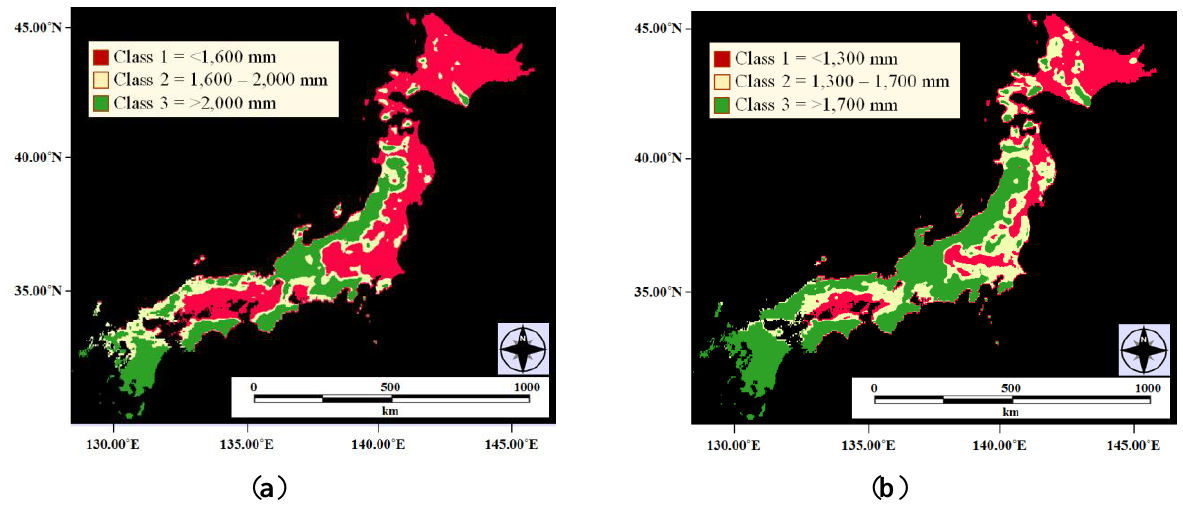
Figure 10. Precipitation data classified using the threshold values for evaluating the growth rate of ( a ) coniferous forests and ( b ) deciduous broadleaf